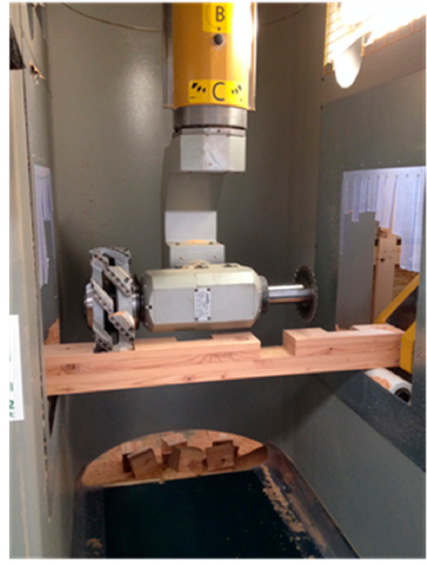
Figure 5. The machine to set up the wooden elements (source: Galloppini Legnami).